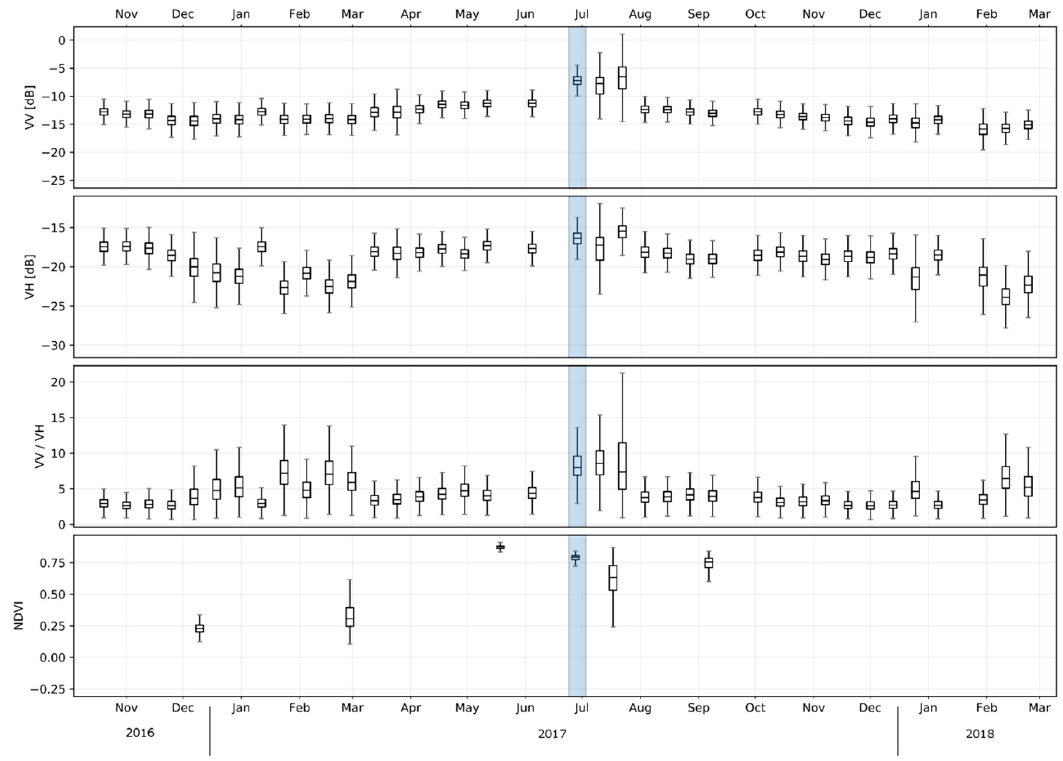
Figure 9. Multitemporal behavior of the backscatter intensity for TFV areas for VV (dB), VH (dB), VV / VH (linear scale), and NDVI values in China. The blue bars mark the analyzed date at the flood event.